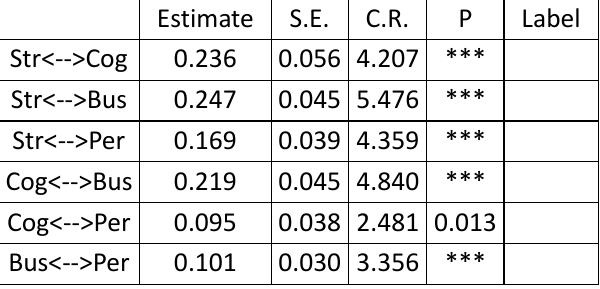
Table 3: Discriminant Validity of CFA test Estimate